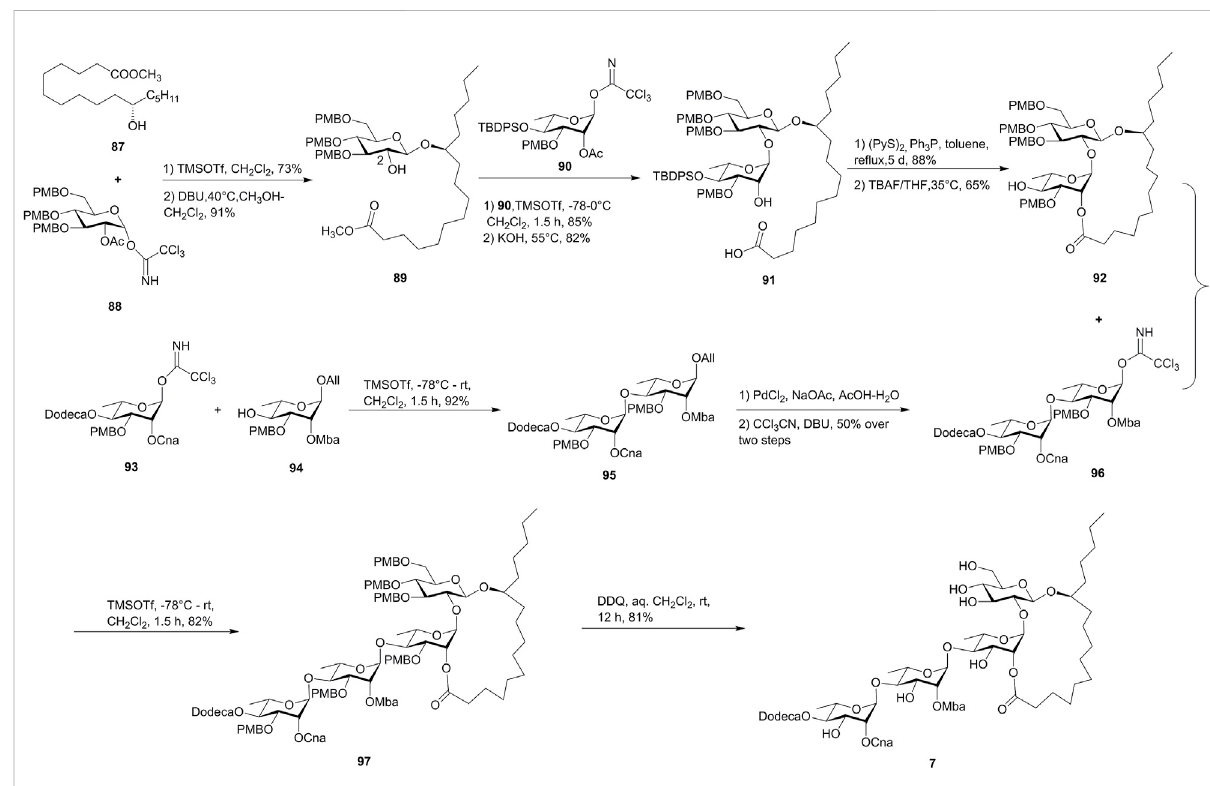
FIGURE 8 Yang ’ s approach toward the synthesis of batatoside L ( 7 ). Dodeca, n-dodecanoyl; Cna, trans -cinnamyl; Mba, 2 S -methylbutyryl; All,